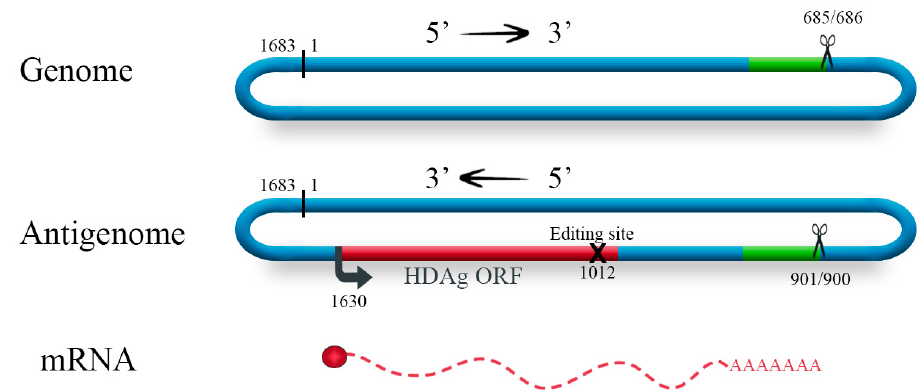
Figure 1. Hepatitis delta virus genomic RNA, antigenomic RNA and mRNA. The delta ribozymes are represented by the green boxes on both strands and the cleavage sites are indicated by scissor symbols. The delta antigen (HDAg) open reading frame (ORF) is represented in the antigenome by the red box, the arrow on position 1630 indicates its transcription start site and the X in the ORF represents the ADAR-1 editing site at a location corresponding to the termination codon of HDAg-S.